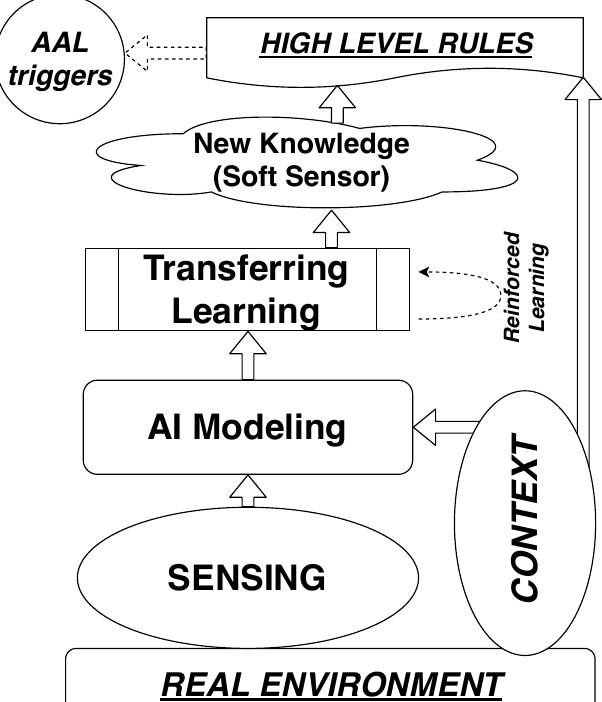
Figure 7. Referential framework proposed. AAL, ambient assisted living; AI, artificial